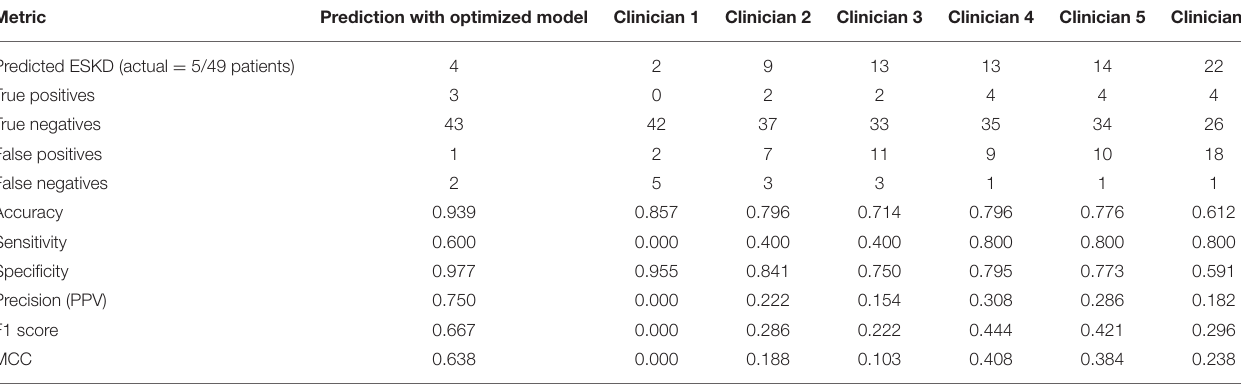
TABLE 3 | Comparative performance of 2-year ESKD predictions by optimized model and expert clinicians. Metric Prediction with optimized model